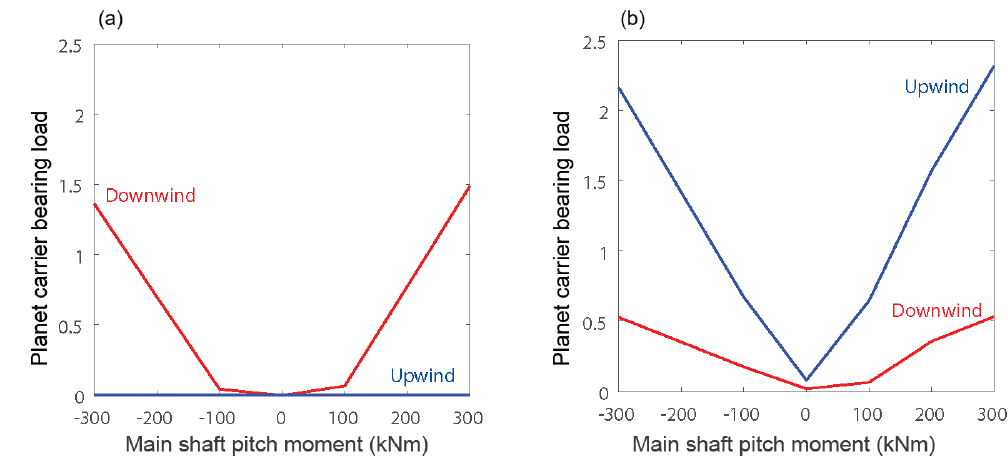
Figure 11. Maximum carrier CRB (a) and TRB (b) loads for all pitch